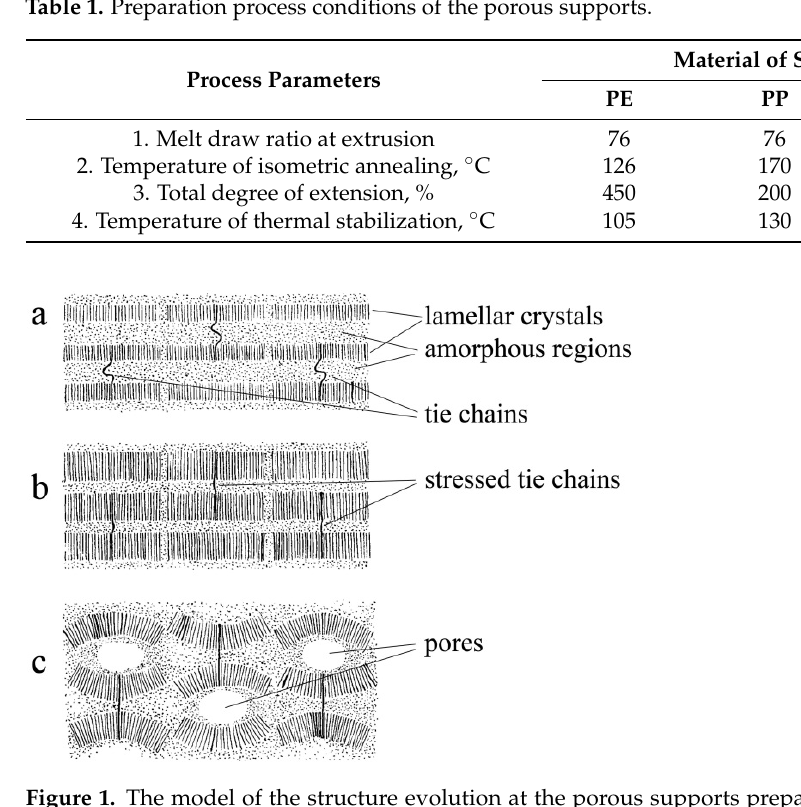
Figure 1. The model of the structure evolution at the porous supports preparation: extruded ( a ), annealed ( b ), and porous ( c ) films. Table 1. Preparation process conditions of the porous supports.